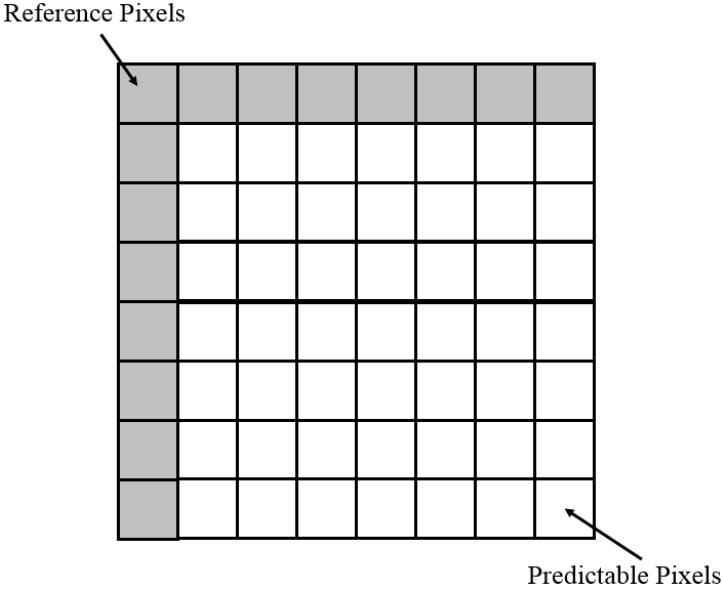
Figure 3. Reference pixels and predictable